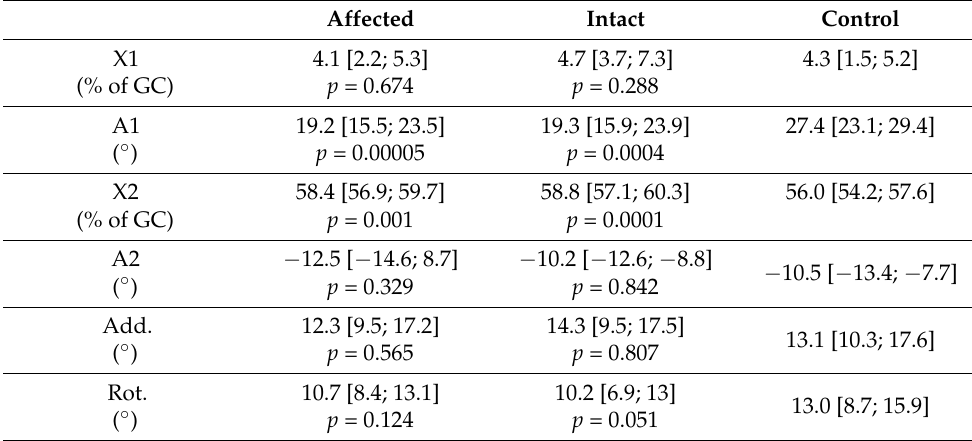
Table 3. Hip movement amplitudes and phases.